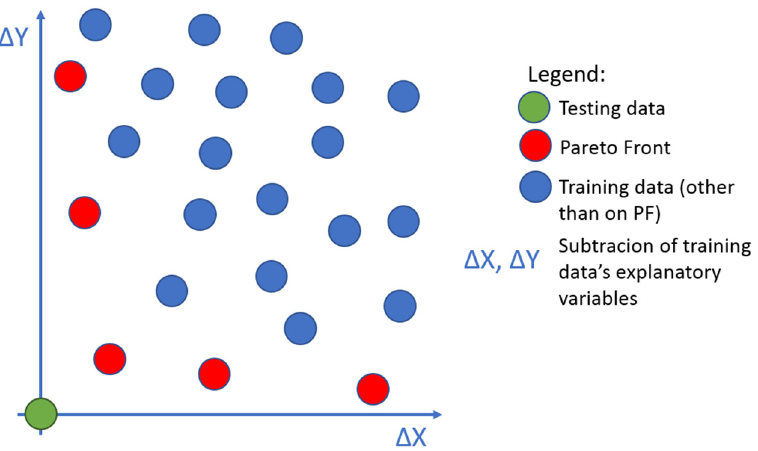
Figure 3. The example of training data belonging to the first Pareto front in one quadrant.